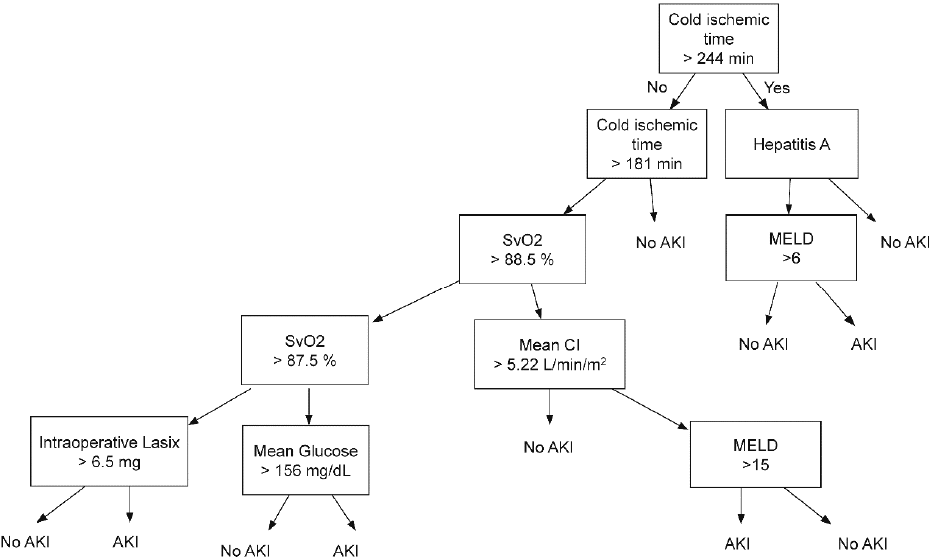
Figure 3. Decision tree showing the classification of patients with and without acute kidney injury. AKI = acute kidney injury; SvO 2 = mixed venous oxygen saturation; MEDL = model for end-stage liver disease.